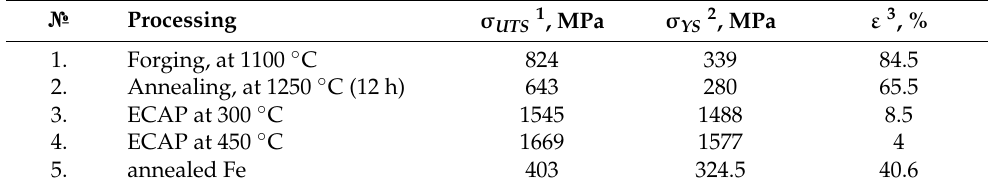
Table 3. Mechanical test results of the Fe–Mn–Pd alloy after various processing (annealed Fe for comparison).